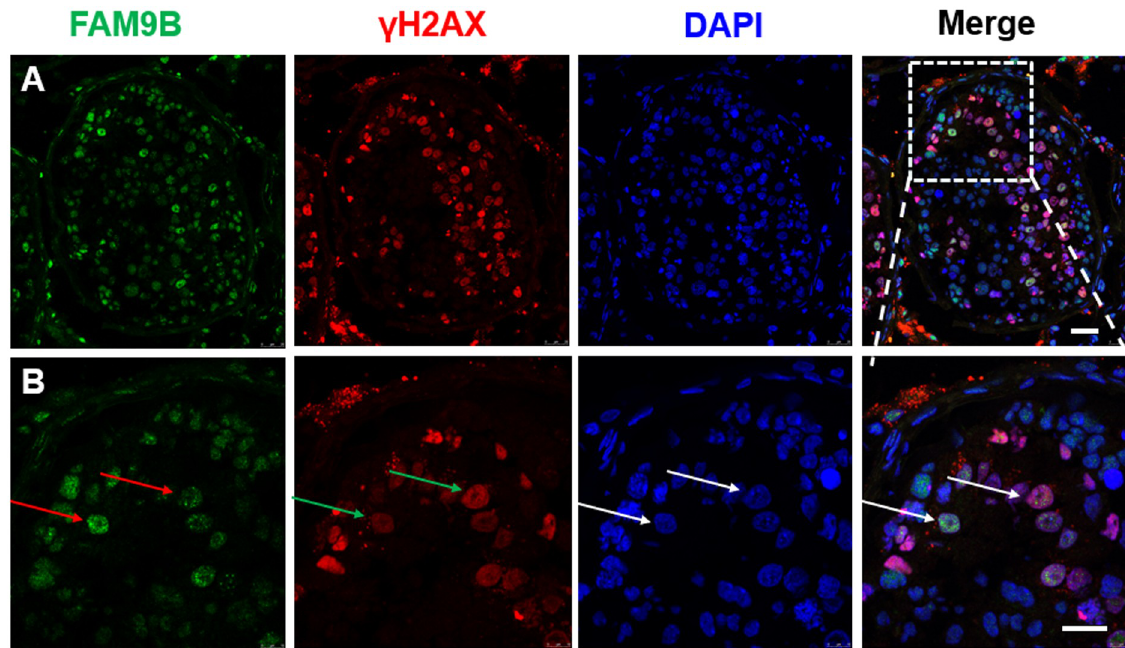
Fig 6. FAM9B and γ H2AX proteins are partly co-localized in spermatocytes. The presence of γ H2AX indicates unsynapsed and unrepaired DSB. FAM9B (green) and γ H2AX (red) are co-localized in the nuclear of spermatocytes (red arrow). FAM9B is partly co-localized with γ H2AX in the spermatocyte nucleus in the first meiotic prophase (white arrow). They have a similar distribution pattern. Scale bar = 10 μ m.